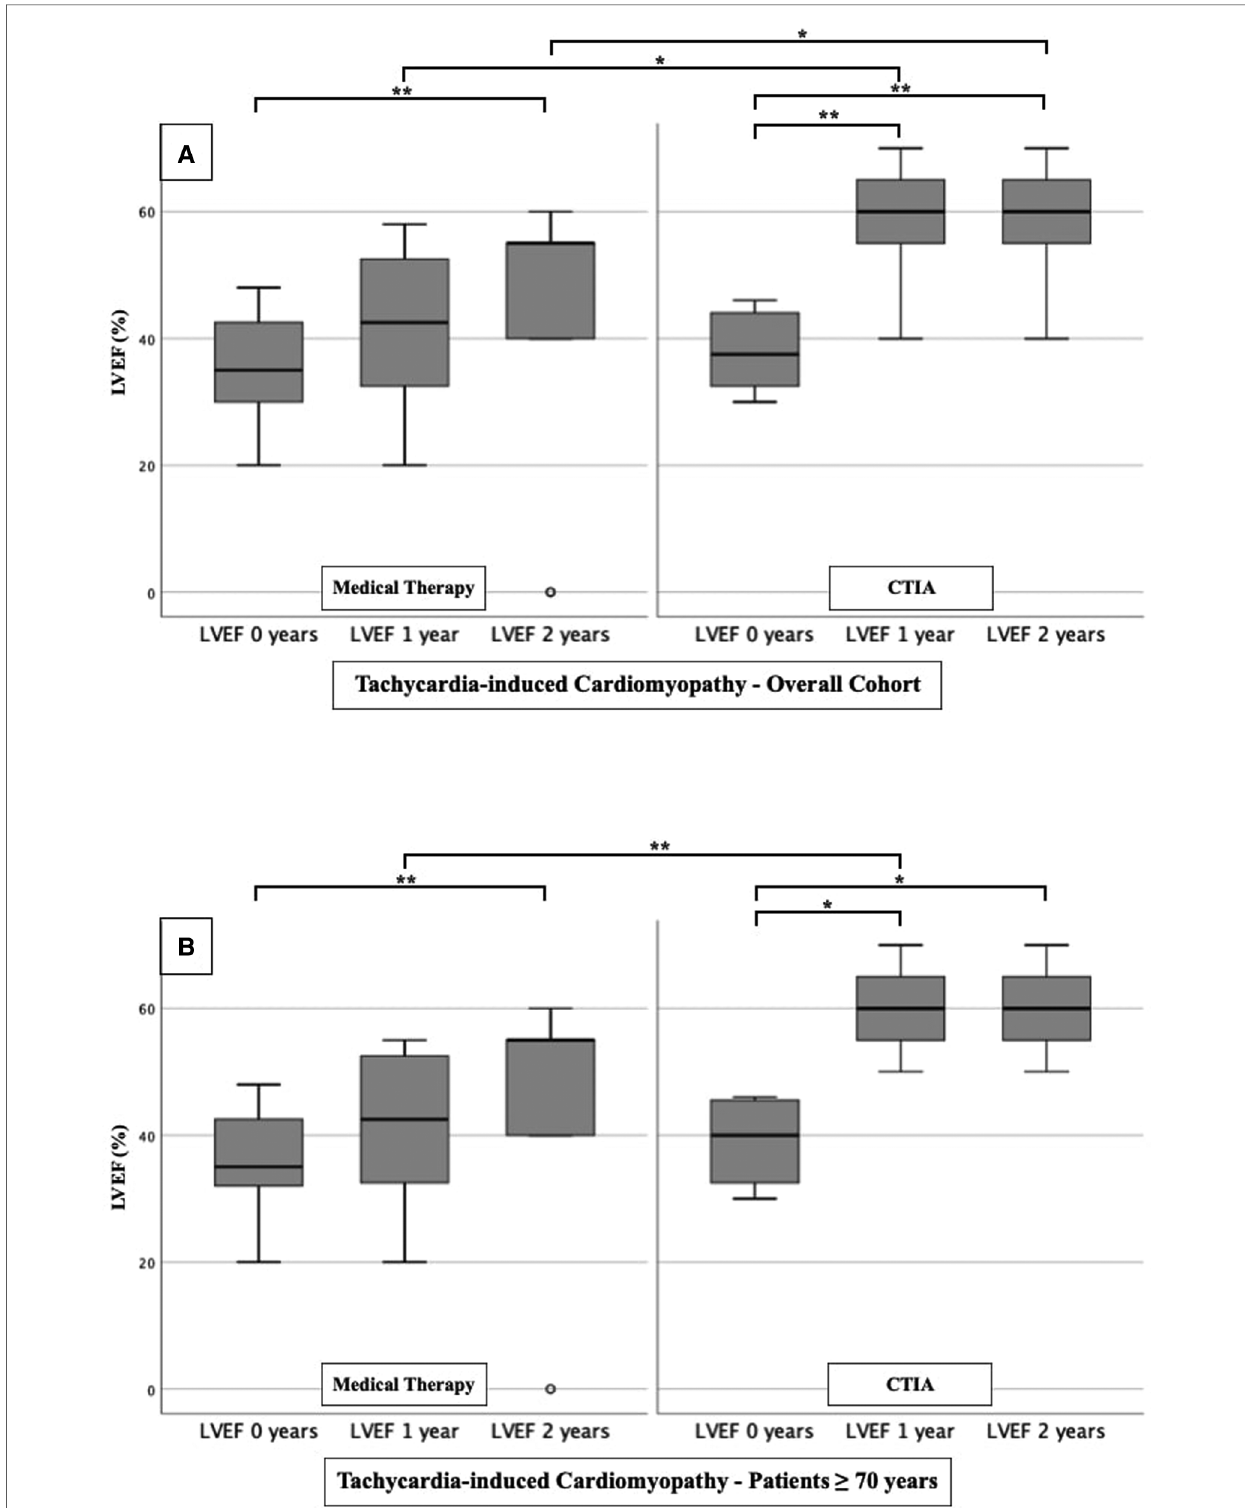
FIGURE 5 LVEF modi fi cations in medical therapy group vs. ablation group of patients with tachycardia-induced cardiomyopathy. ( A ): All patients with tachycardia- induced cardiomyopathy. ( B ): Patients ≥ 70 years with tachycardia-induced cardiomyopathy. * p ≤ 0.050; ** p ≤ 0.010; *** p ≤ 0.001.